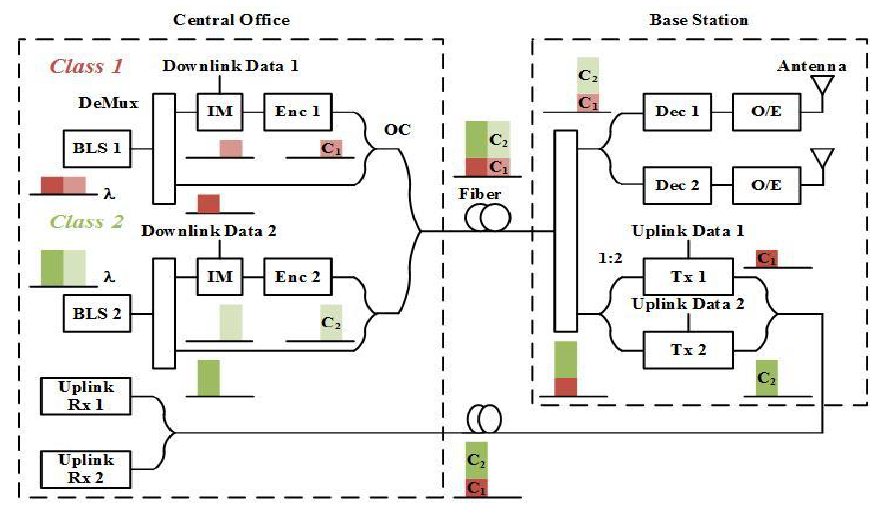
Figure 2. Configuration of the wavelength-reused radio-over-fiber (RoF) network with power control technique.